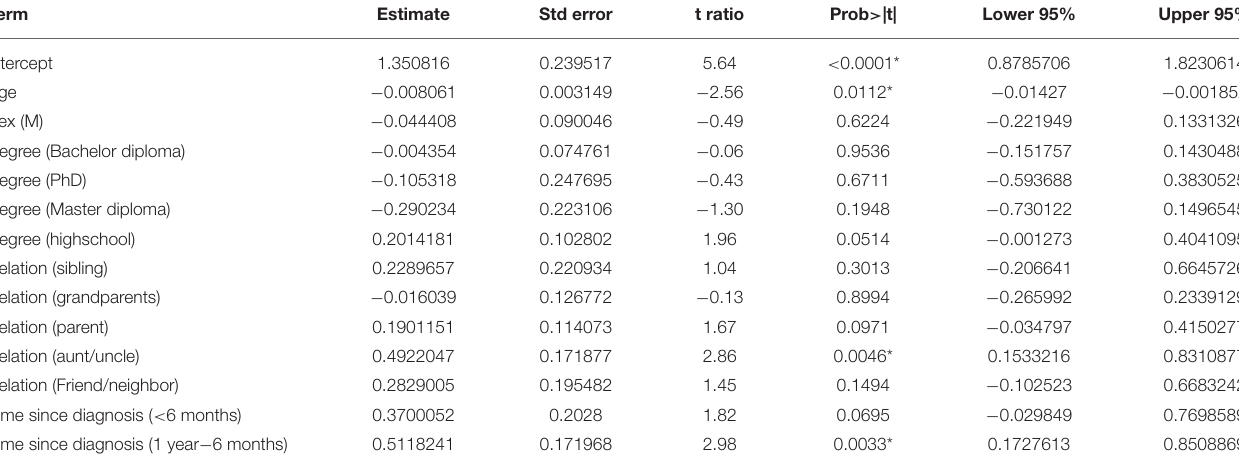
TABLE 4 | Impact of the demographic factors on the affiliate stigma